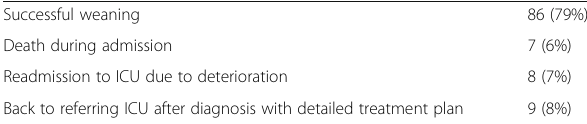
Table 1 (abstract 001752). Outcomes of treatment